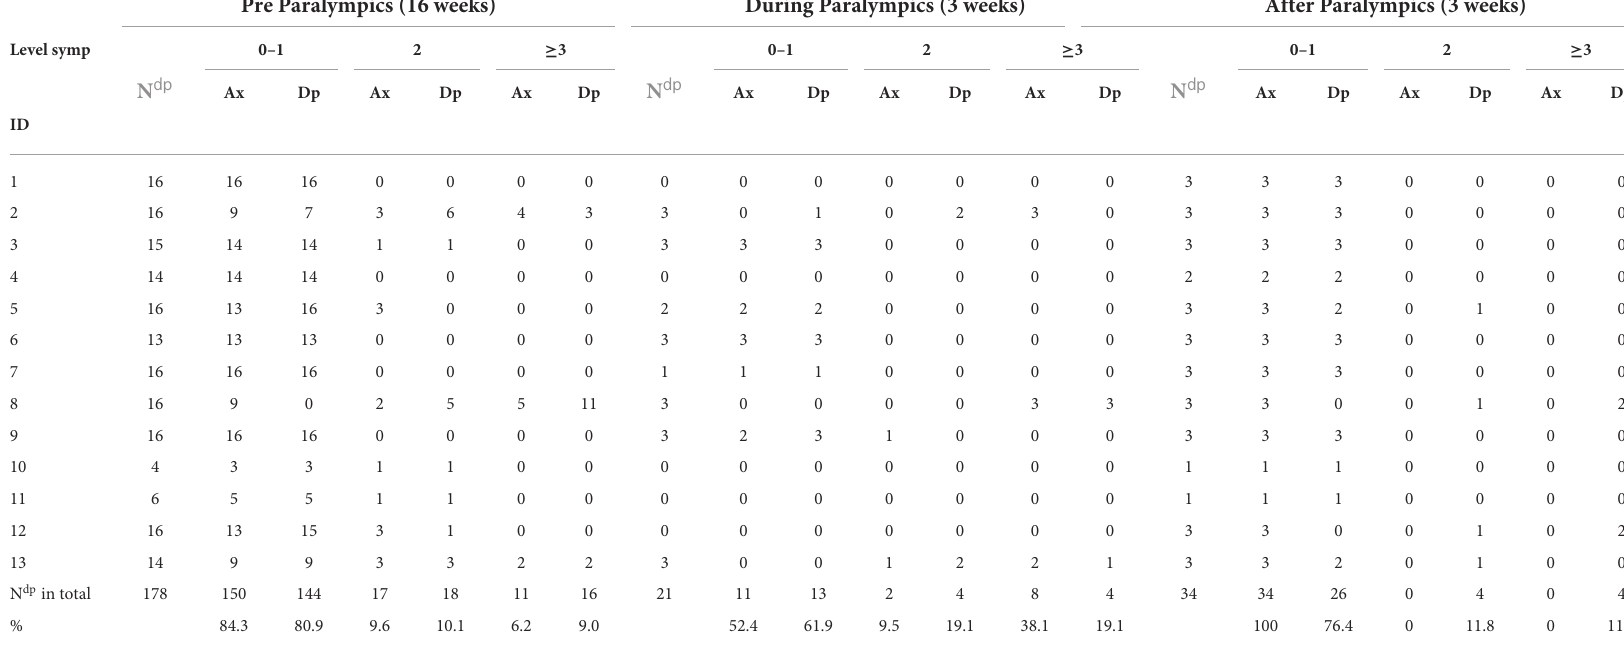
TABLE 1 Overview of weeks with symptoms of anxiety and depression before, during and after